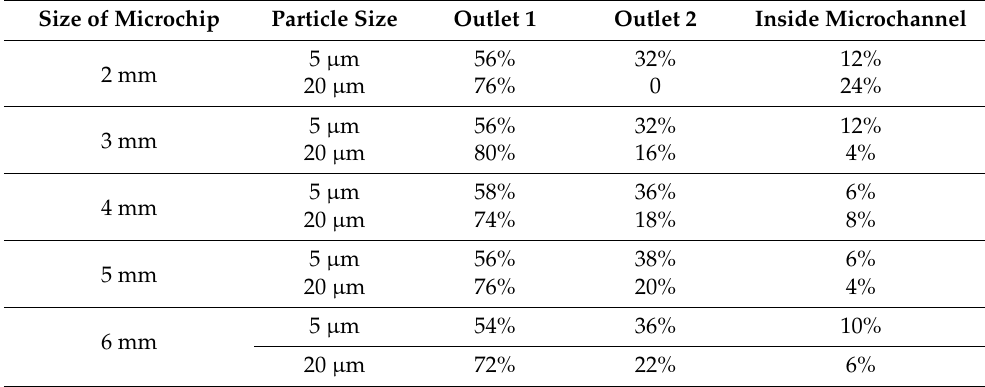
Table 1. Particle capture distribution in various corrugated dragonfly wing microchips. Size of